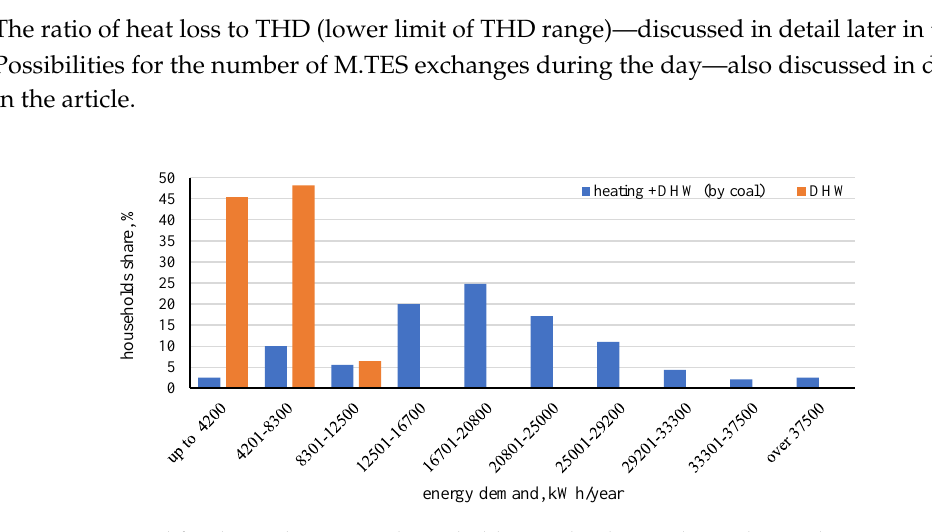
Figure 4. Demand for thermal energy in households in Poland. Data limited to coal sources. Source: own study, based on [30,31,50]. This value applies to heat for central heating (CH) and domestic hot water (DHW). Lower